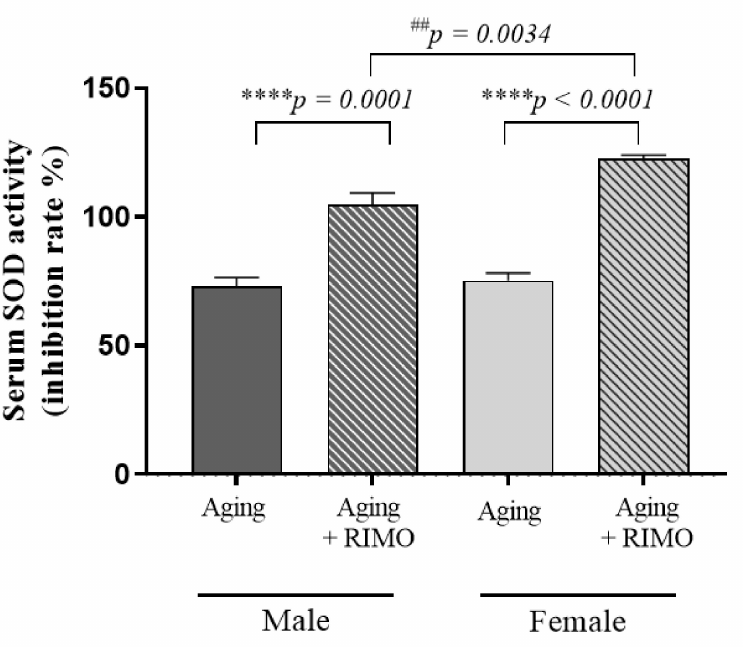
Figure 4. The effects of rimonabant treatment on serum SOD activity in aged animals (SOD ex- pressed as inhibition rate %). Results are shown as means S.E.M. n = 6–8. **** p < 0.0001: Statistical significance between rimonabant-treated and untreated, sex-matched aging ## p < 0.01: Statistical significance between the rimonabant-treated female and male aging rats. RIMO = rimonabant, SOD = superoxide dismutase.